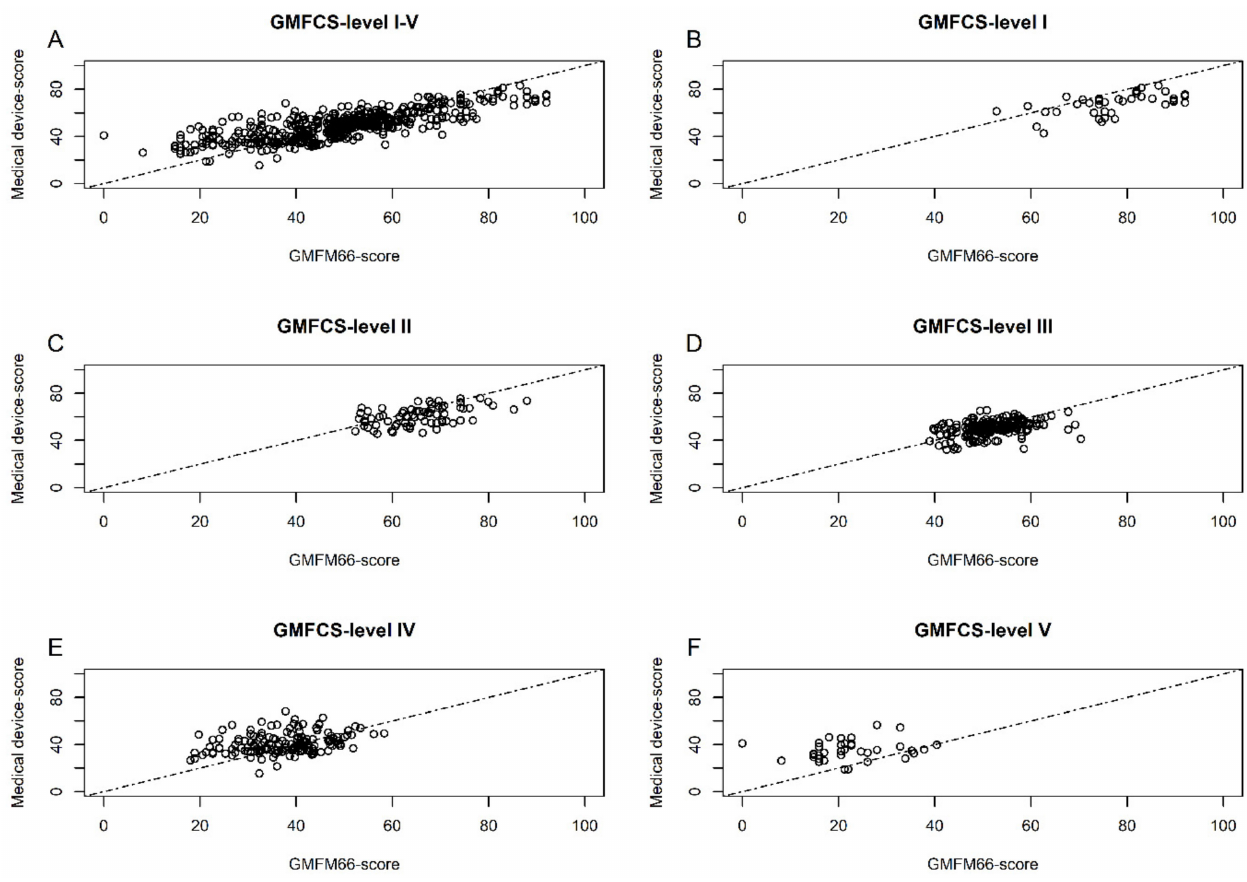
Figure 3. ( A – F ) Scatterplots with the unit line for the MDS against the GMFM-66 by GMFCS-level.